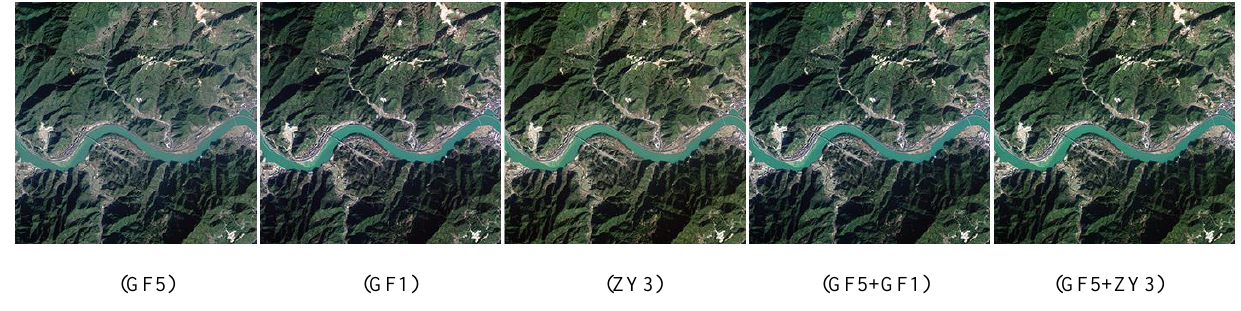
Figure 2. Comparison of GF5, GF1, ZY3 fusion